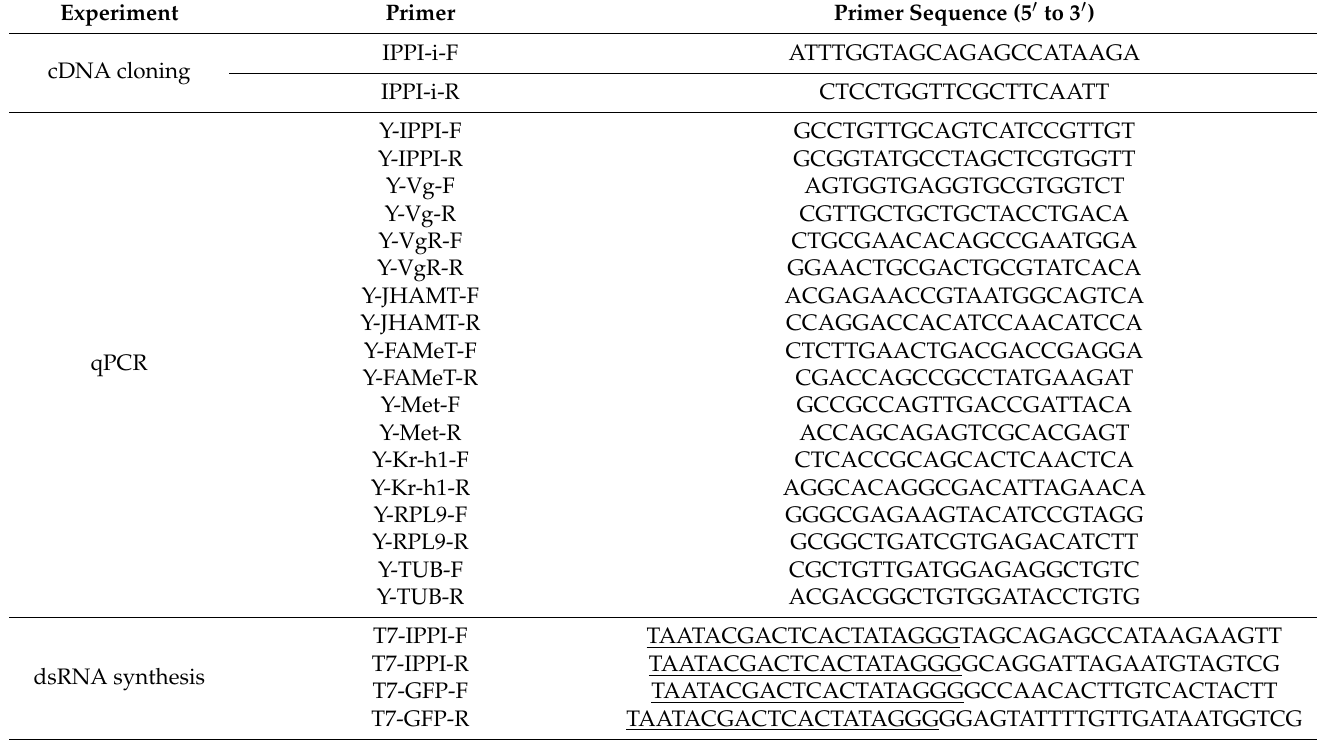
Table 1. Primers used in this